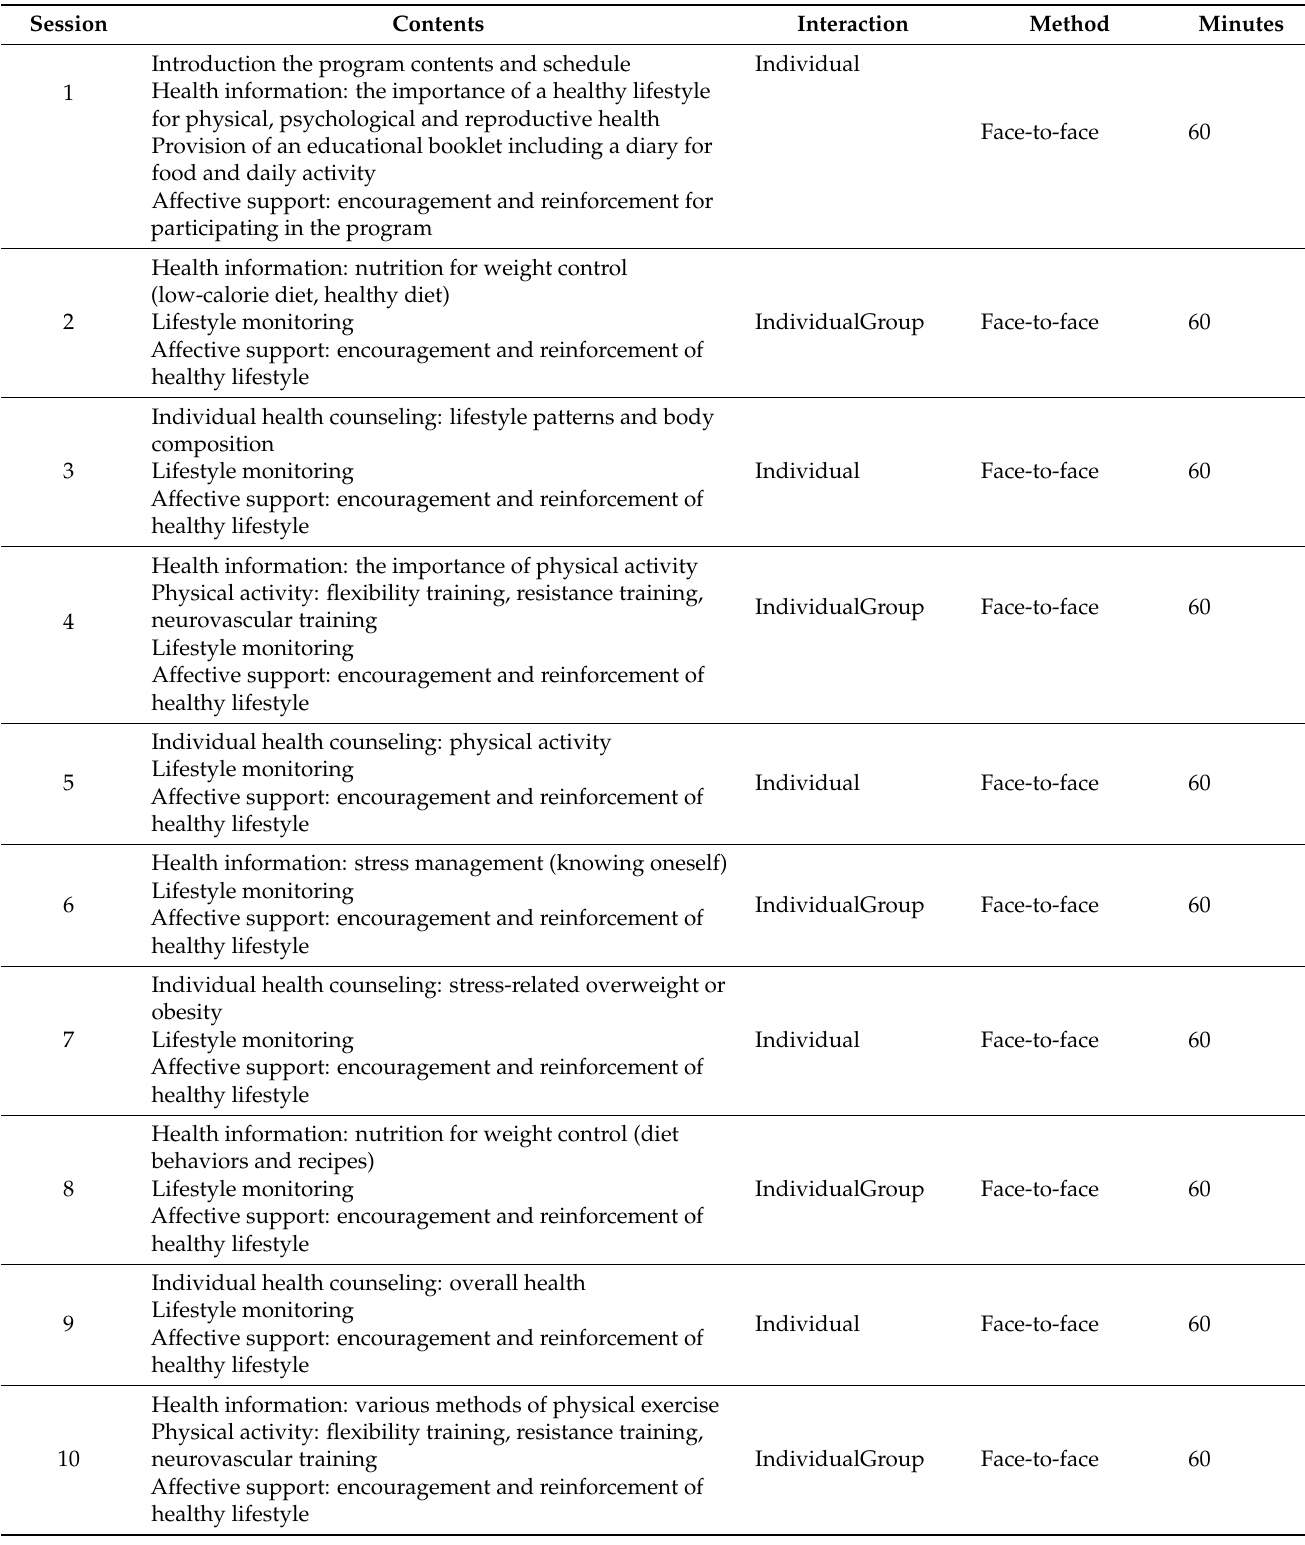
Table 1. Contents of the lifestyle